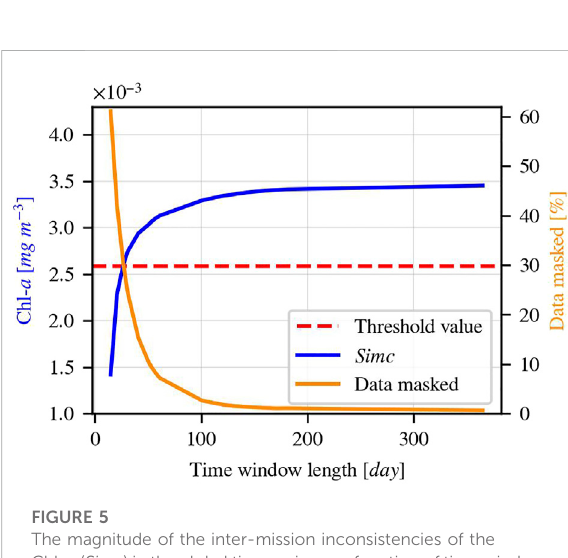
FIGURE 5 The magnitude of the inter-mission inconsistencies of the Chl- a ( Simc ) in the global time series as a function of time window length (blue) used in the TGDM (see text for details) and the coupled amount of data records masked after TGDM (orange). The dashed red line represents a threshold value de fi ned by the standard deviation of the noise in the time